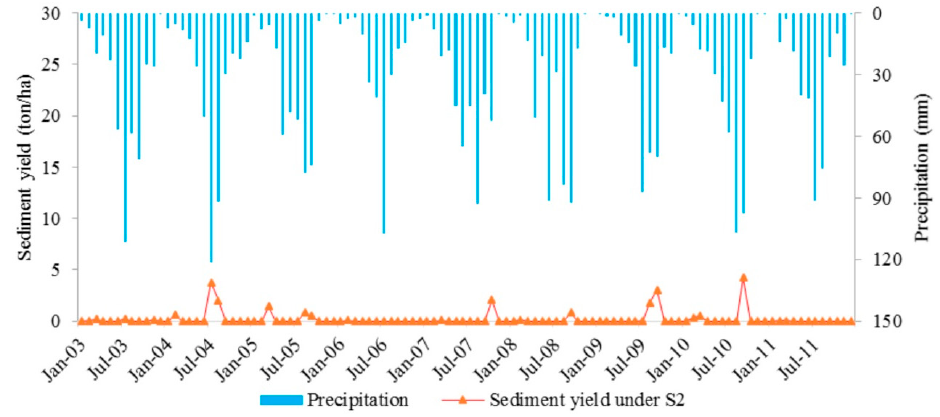
Figure 9. Monthly simulated sediment yield under different climate scenarios: Scenario 1 ( S 1) and Scenario 2 ( S 2). Table 8. The rate of sediment yield in the USK river basin during 1986–2012. Sub-Basin